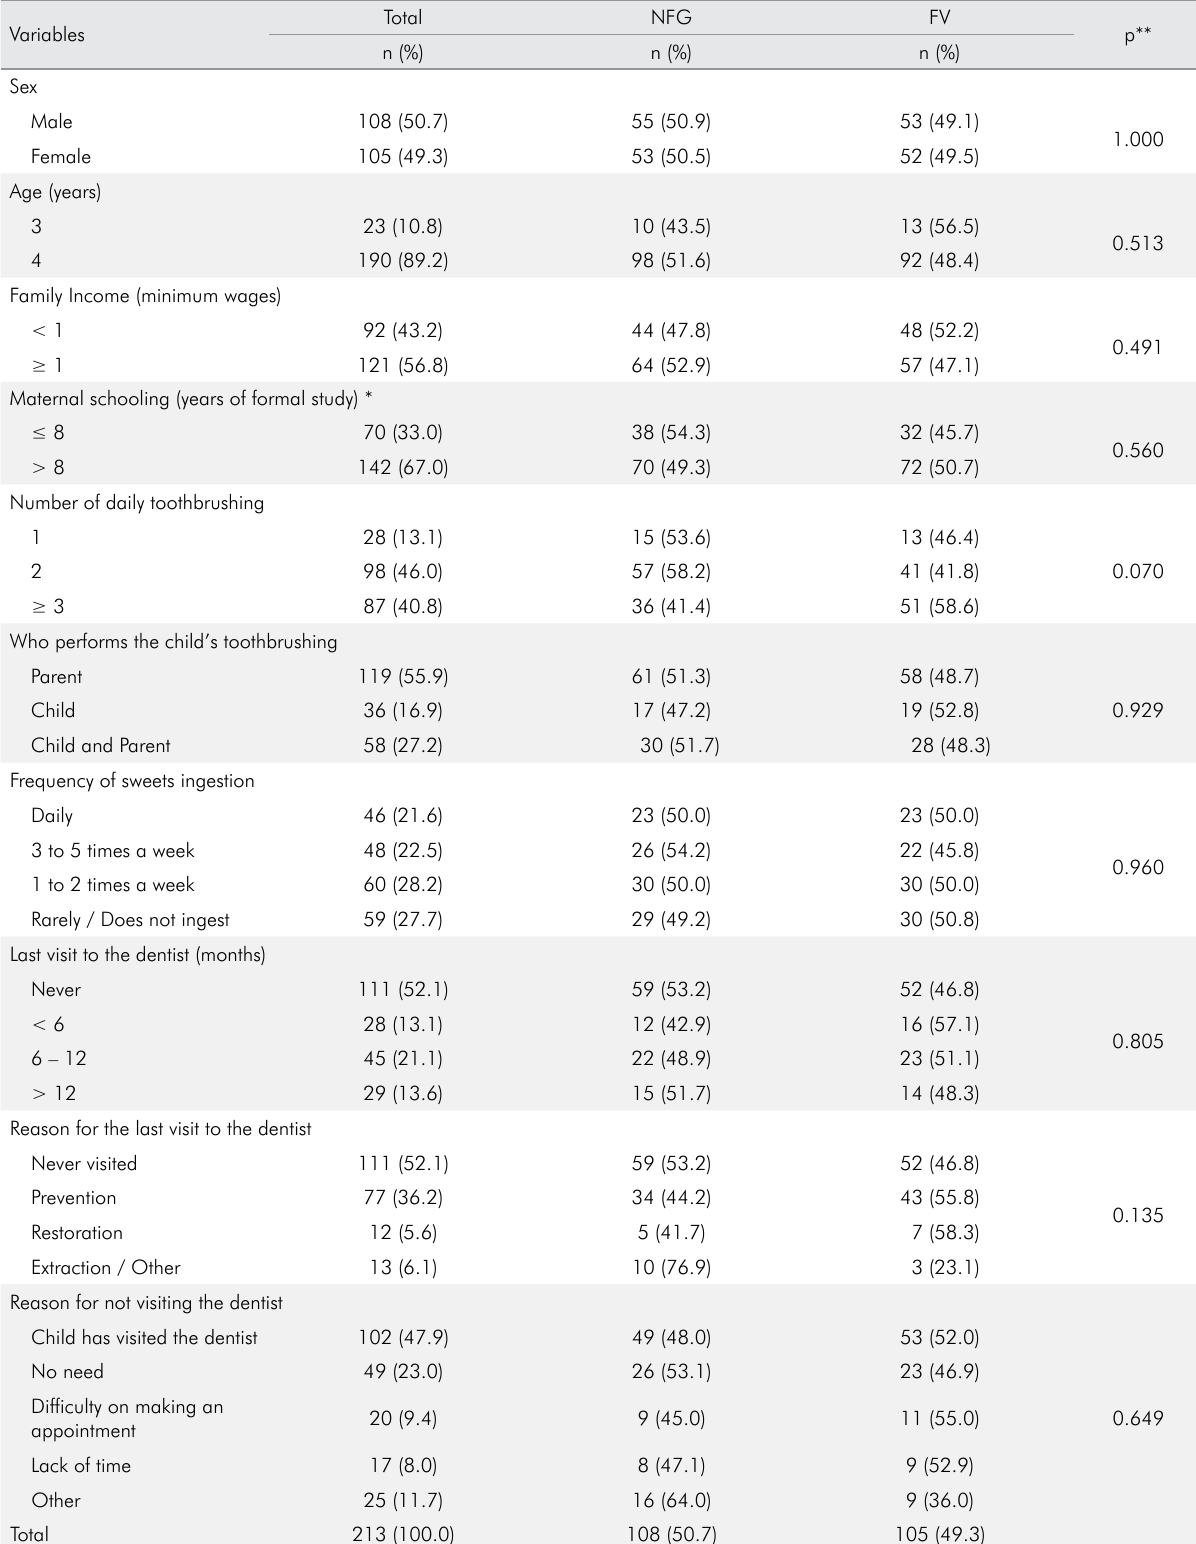
Table 1. Socioeconomic/demographic characteristics and oral health habits of the participants in the NFG and FV groups.